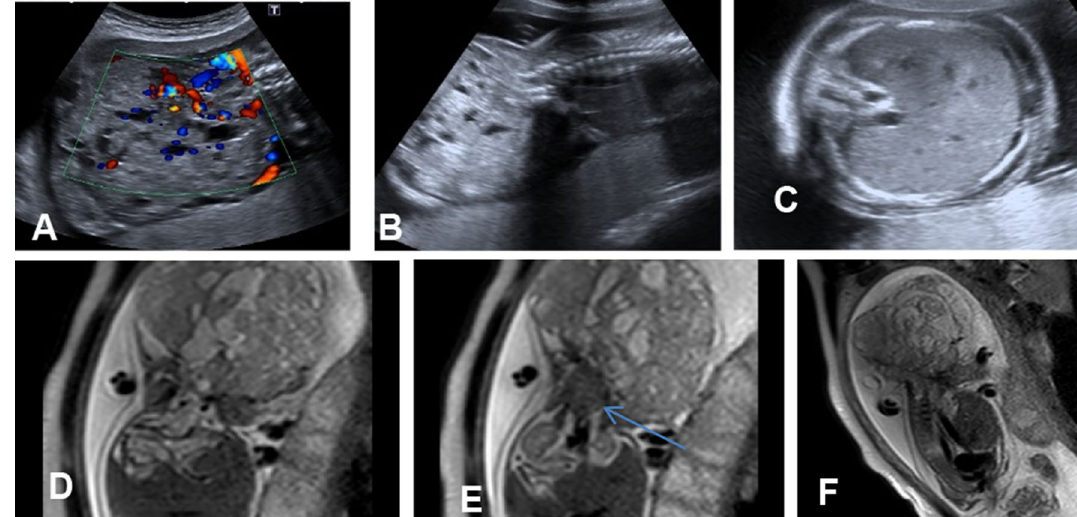
Fig. 5 A 22-year-old pregnant female with late 1st trimester and another early 2nd trimester US revealing large fetal sacral mass lesion. Ultrasound findings: A , B Axial and coronal sections of the fetal lower back showing a large mixed solid and cystic mass lesion arising from the fetal sacral region with small intra-spinal extension and extensive neovascularization on Doppler interrogation. C Axial image at the level of fetal liver revealing marked skin thickening and subcutaneous edema. MRI findings: D , E , F axial, and sagittal T2WIs revealing the mixed solid and cystic sacral mass lesion with its smaller pelvic extension (arrowed) at the level of the fetal urinary bladder and actual size of intra-spinal extension (arrowed). Note associated diffuse fetal subcutaneous edema. Combined US and MRI Diagnosis: A large mixed solid and cystic highly vascular fetal sacrococcygeal teratoma with a smaller intra-pelvic and intra-spinal extension (stage IV) and complicated fetal hydrops. IUFD at 30